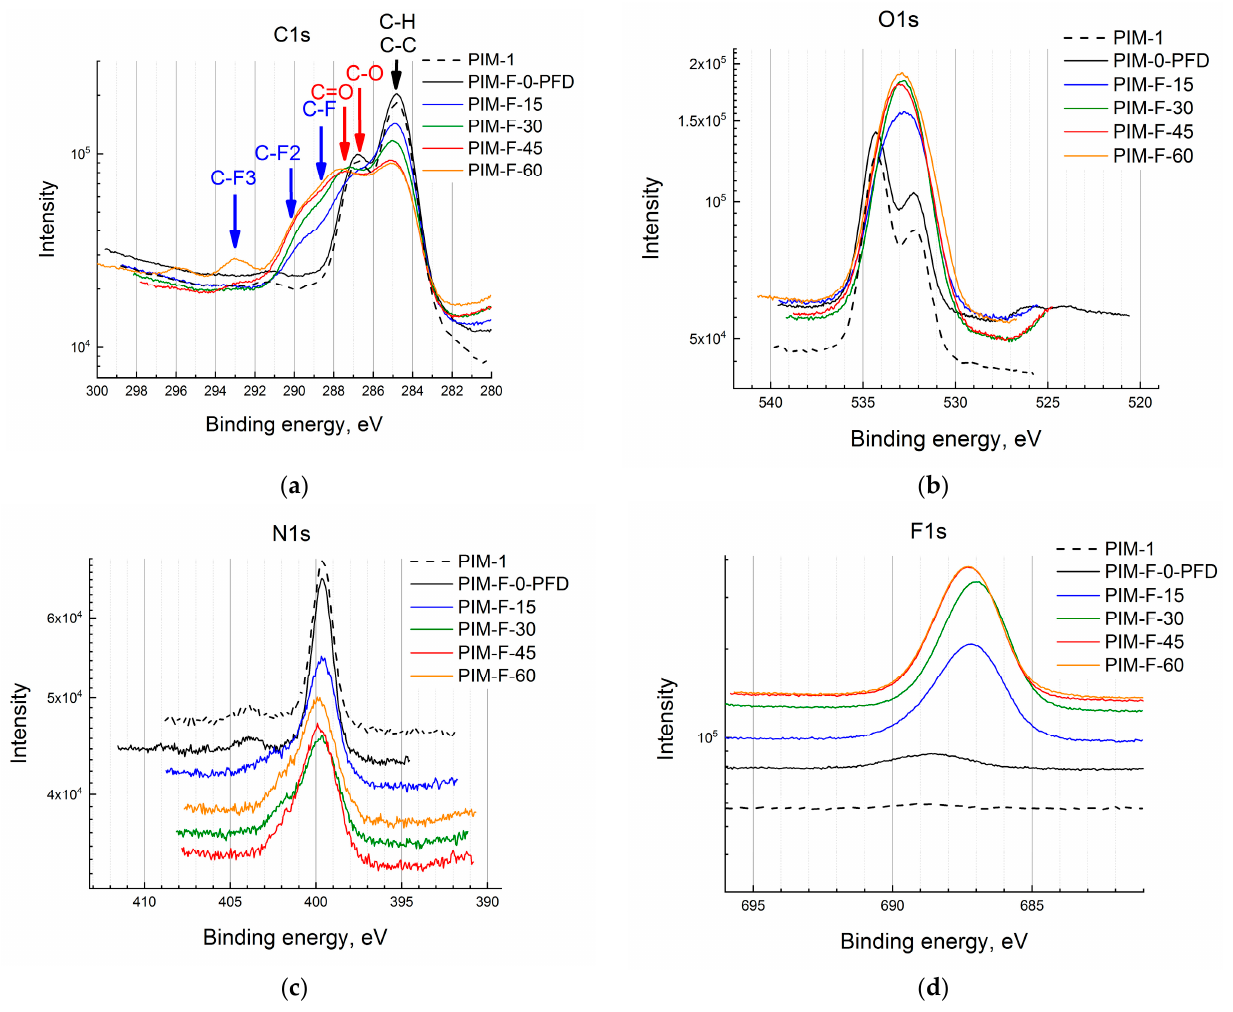
Figure 8. XPS spectra of C1s ( a ), O1s ( b ), N1s ( c ) and F1s ( d ) bands in the PIM-1 sample for control sample (PIM-F-0-PFD) and PIM-1 films fluorinated for 15 (PIM-1-F-15), 30 (PIM-1-F-30), 45 (PIM-1-F- 45) and 60 min